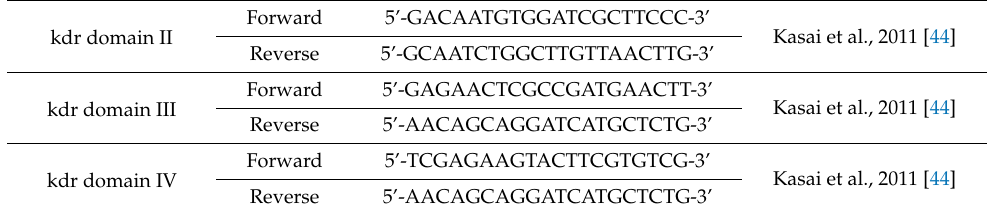
Table A1. Primers Used for Amplification of Three Domains of kdr .